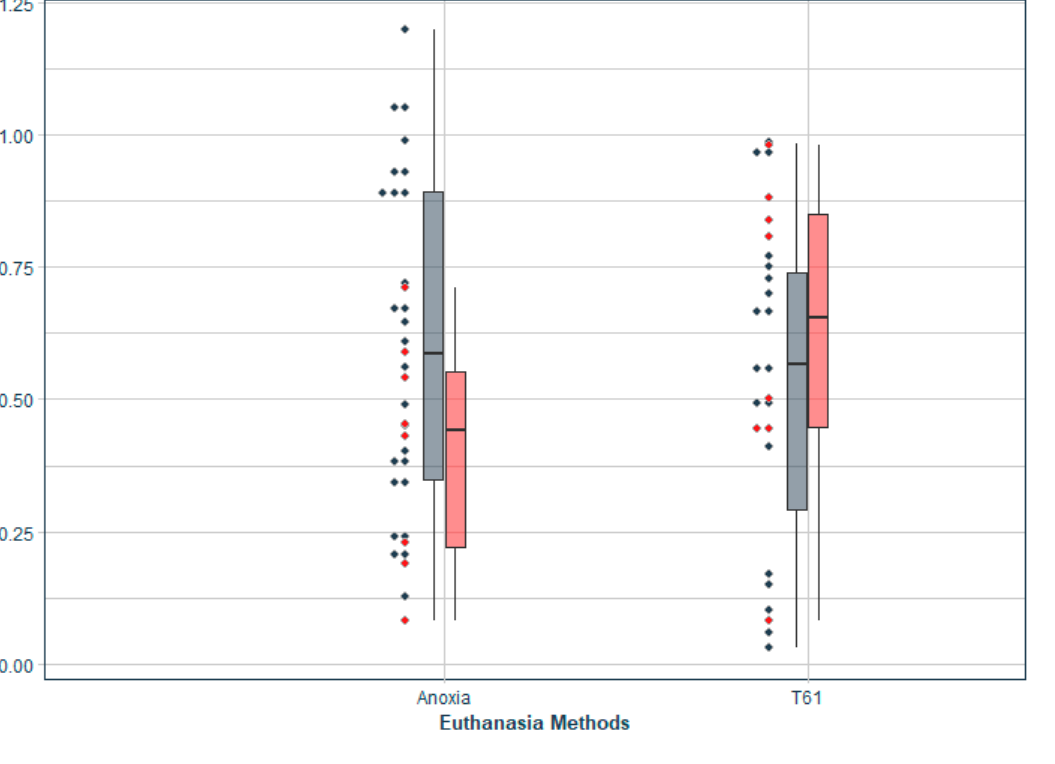
Figure 3. Details of samples retained after filtering. All samples with RNA concentration above 50 ng/µL and a A260/230 ratio above 1.0 were retained for further evaluation. CM: cremaster muscle; DIR: deep inguinal ring; SIR: superficial inguinal ring.